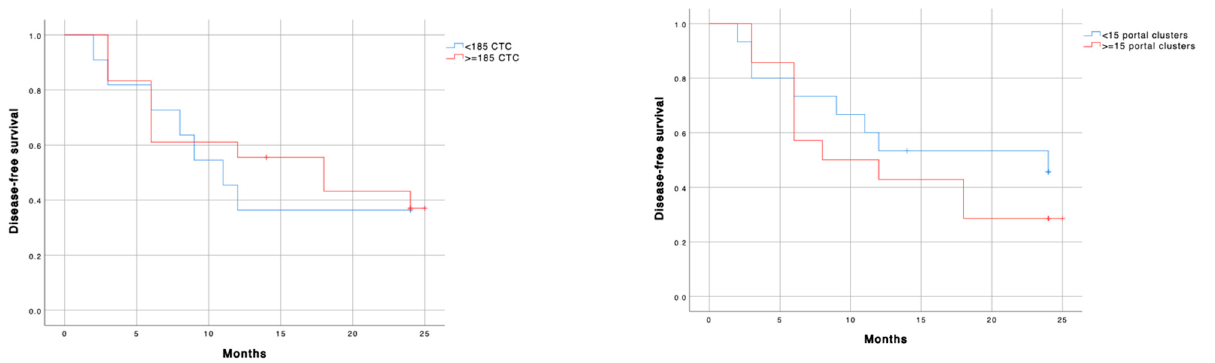
Figure 4. Disease-free survival according to left) PV-CTC ´ s cut-off; and right) PV-cluster number ´ s cut-off. Blue line: low cellular expression; red line: high cellular expression. <185 CTC (28.5 vs. 25.0 months; p = 0.647) and <15 clusters (29.0 vs. 22.5 months; p =